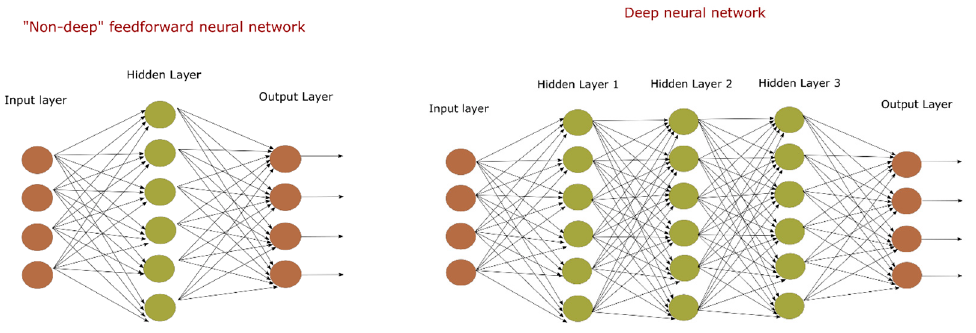
Figure 2. A feed-forward neural network (a single hidden layer, left ) and a deep feed-forward neural network (multiple hidden layers, right ).